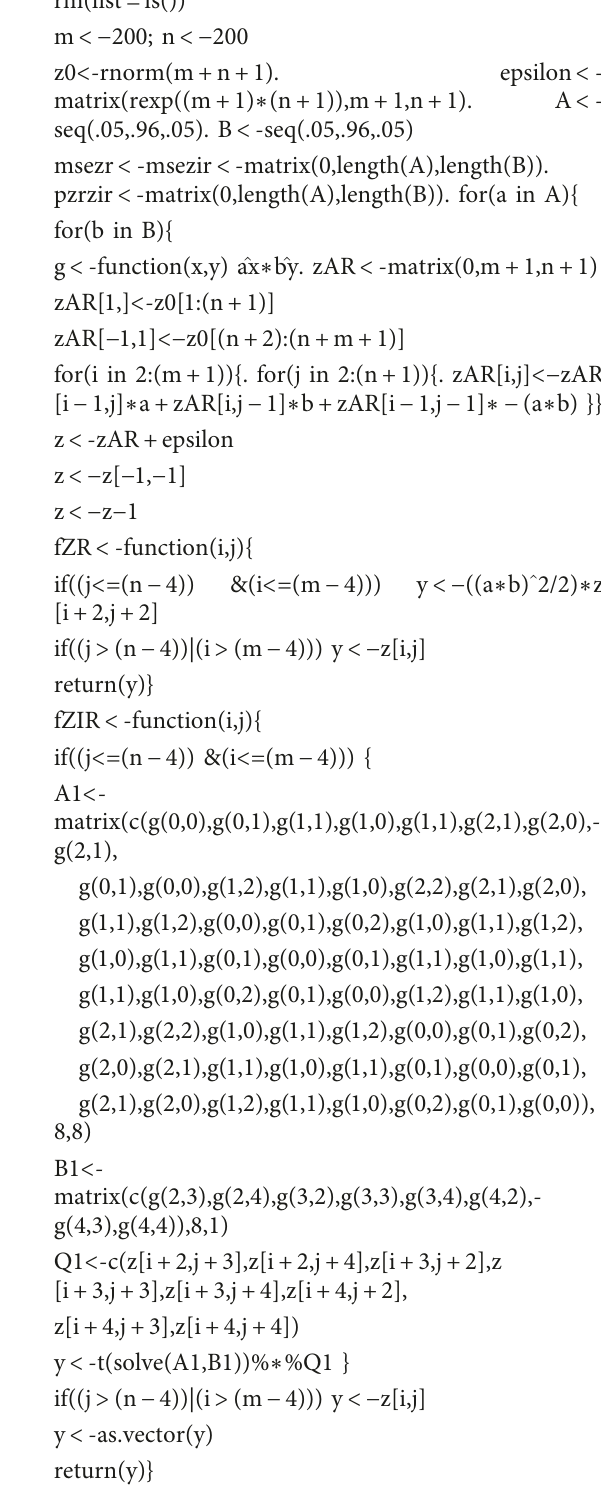
Comparison between redundant and nonredundant sampling with exponential